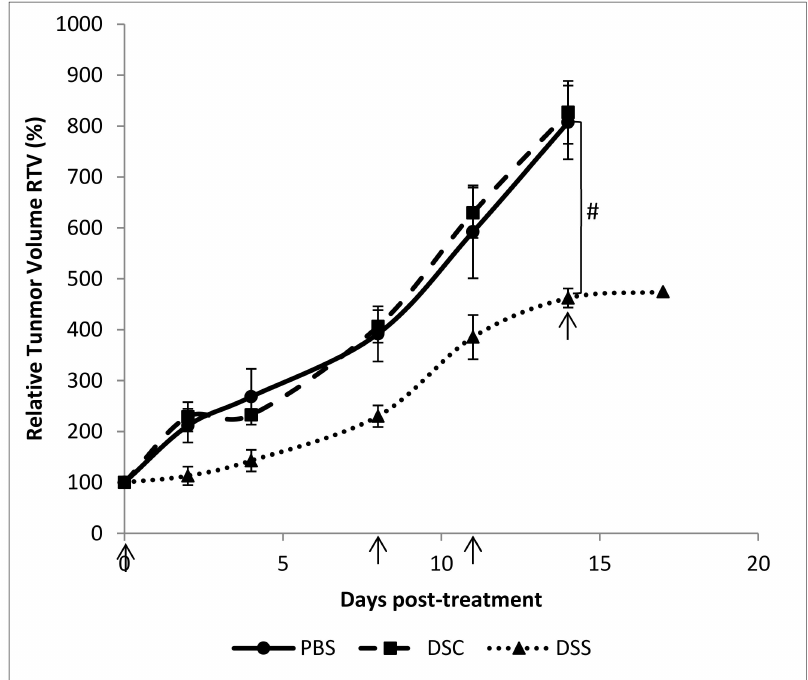
Figure 4. Relative tumor volume of mice bearing 4T1 cells orthotopically implanted and treated with DSC and DSS aqueous extracts at 5 mg / kg (10, 18, 21 and 24 days post-implantation). Results shown are mean values ± standard error of the mean ( # p < 0.05) according to one-way ANOVA using Origin